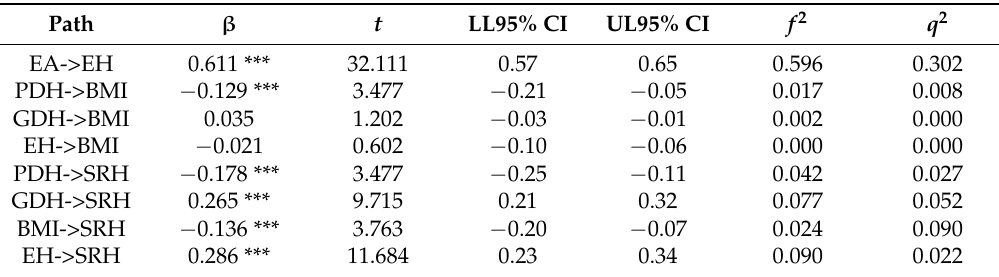
Table 2. Path coefficients of structural model.